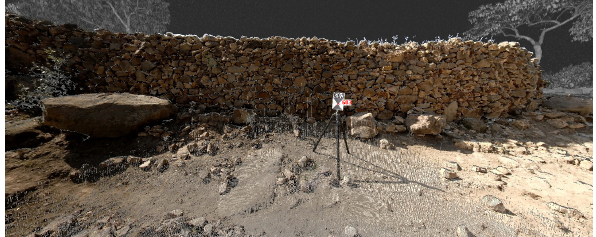
Figure 3: Laser scanner IMAGER 5006 (left), with mounted Nikon D40 camera (centre) and Nikon D200 camera on nodal point adapter